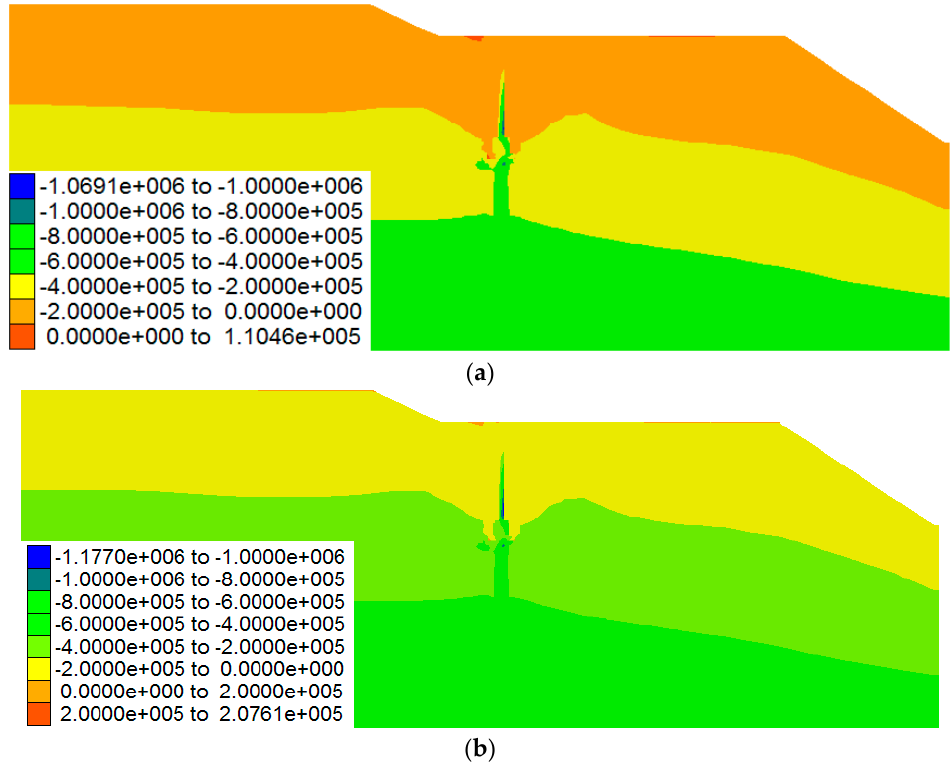
Figure 15. Stress distribution in the analysis area. ( a ) Nephogram of maximum principal stress. ( b ) Minimum principal stress nephogram. ( c ) YZ in-plane shear stress nephogram.